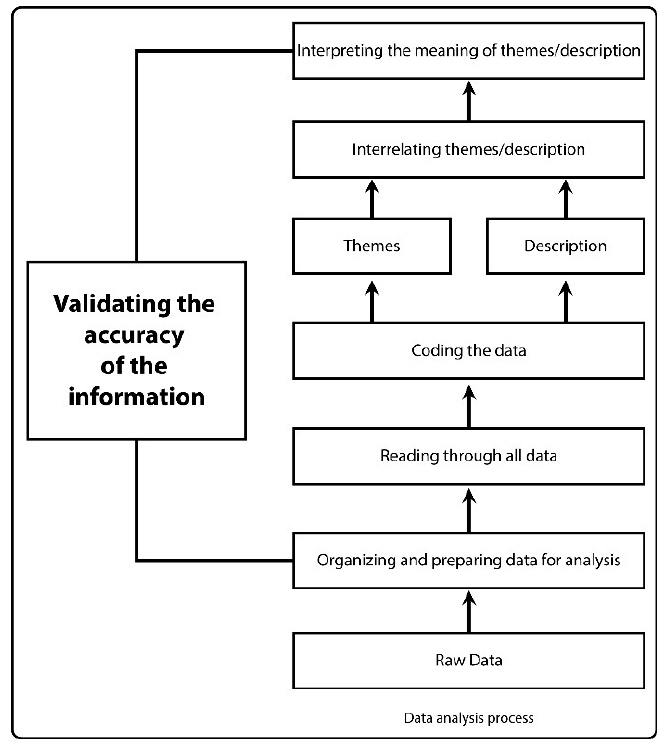
Figure 2. Data analysis process for the thematic analysis method.